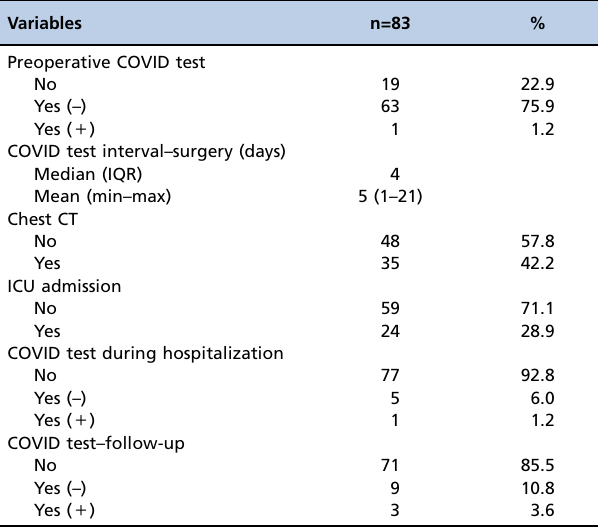
Table 5 - Tests and screening protocol follow-up in the COVID group. Variables n=83